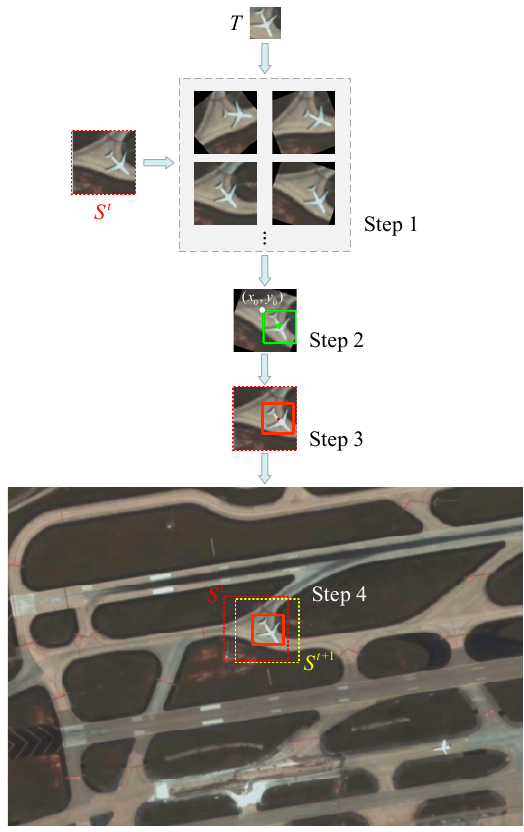
Figure 7. Tracking procedure for matching aircraft in rotated search area images. Figure 8. Tracking procedure for matching aircraft in rotated search area